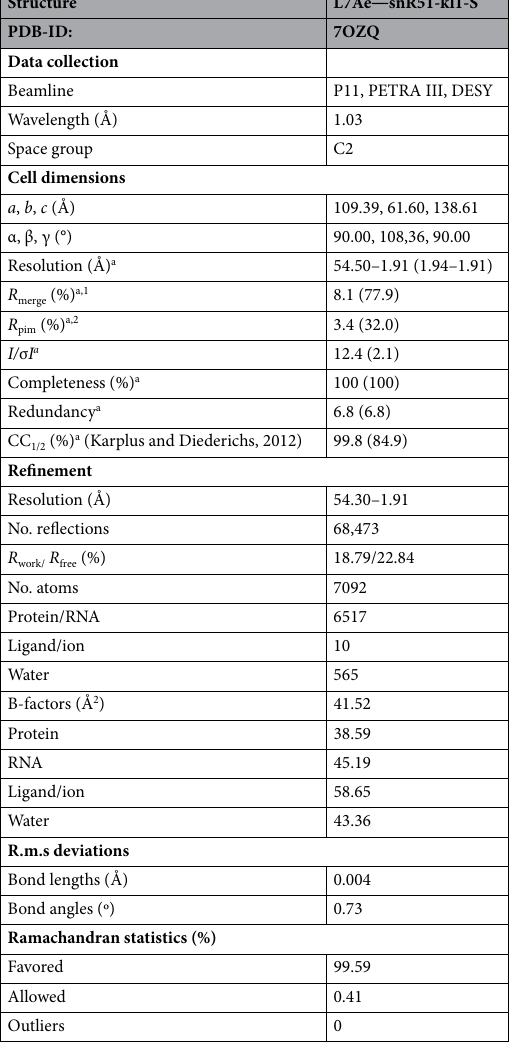
Table 1. Crystallographic data collection and refinement statistics. a Values for the highest resolution shell are shown in parentheses. 1 R merge = Σ h Σ i |< I h >—I h,i |/Σ h Σ i I h,i , where h enumerates the unique reflections and i are their symmetry-equivalent contributions. 2